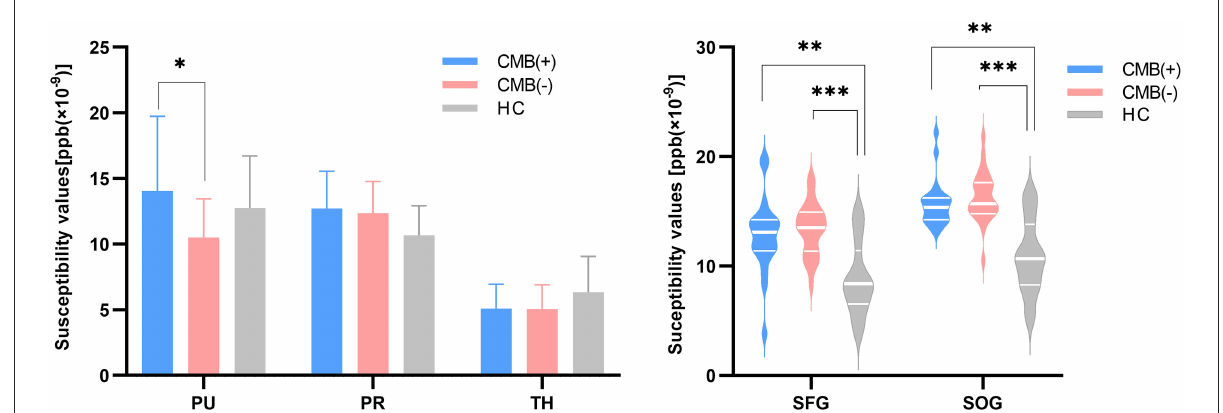
FIGURE5 The iron content of rich-club nodes (grouped by the presence of CMB). The histogram expresses normal distribution data; “T” denotes standard deviation. The violin diagram expresses abnormal distribution data; three transverse lines denote the 75th percentile, median, and 25th